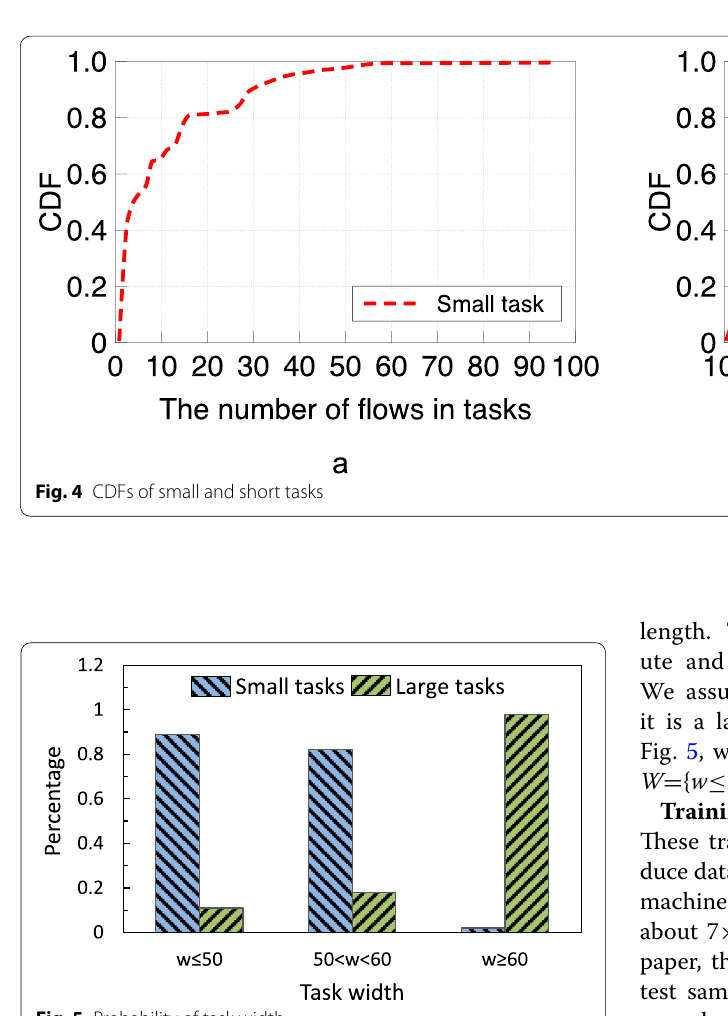
Fig. 5 Probability of task